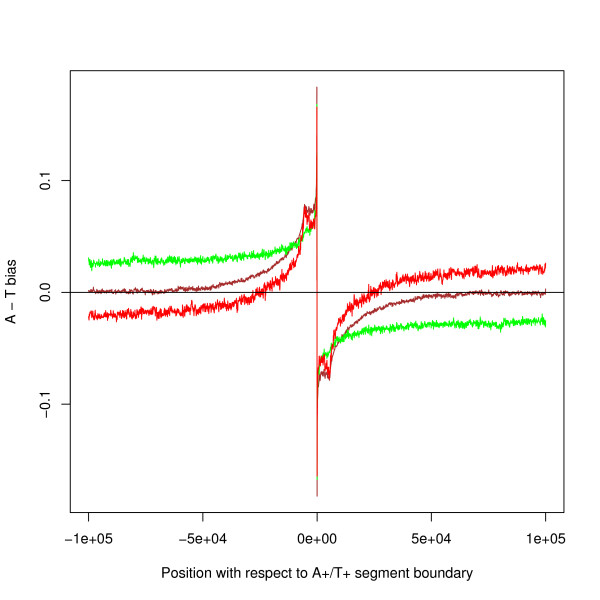
Bias with respect to A+/T+ segment boundary – estimates for combined effect of transcription. The brown line shows the AT-bias where there is no transcription. The green line shows the AT-bias where there is transcription in the direction from the A+/T+ boundary to the T+/A+ boundary. The red line shows the bias where there is transcription in the opposite direction. All lines show moving averages over 100 bases.